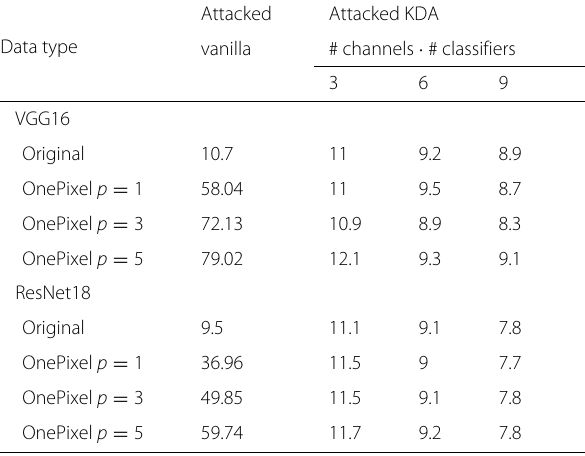
Table 4 Classification error (%) on the first 1000 CIFAR-10 test samples for the direct black-box OnePixel